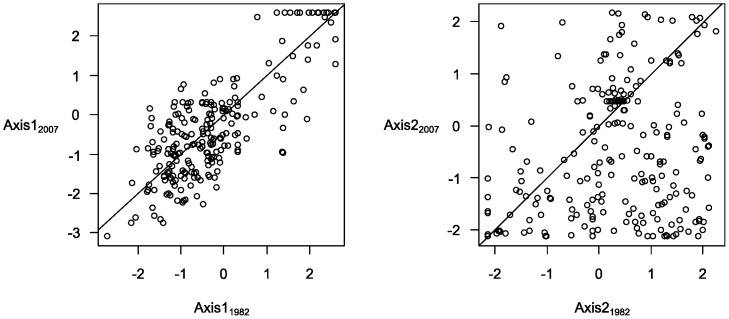
Position of the stations along the Axis 1 and Axis 2 of the PCA in 1982 and 2007.The equation of the line is y = x.